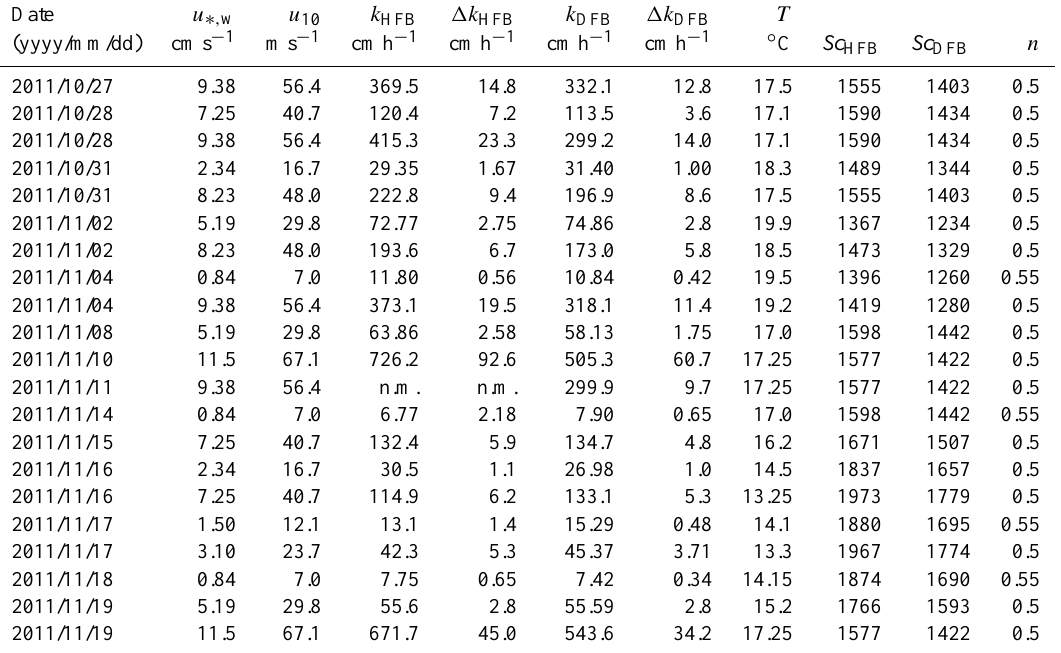
Table A1 summarizes all measured experimental data: fric- tion velocity, wind speed, mean water temperature, as well as both tracer’s transfer velocities and Schmidt numbers. Table A1. Transfer velocities k (not scaled to Sc =600) measured in the Kyoto high-speed wind-wave tank for tracers 1,4-difluorobenzene (DFB) and hexafluorobenzene (HFB) and their respective uncertainties 1k . “n.m.” means not measured. The wind speed u 10 and water- sided friction velocity u ∗ , kindly provided by the Japanese colleagues, are also given. T denotes the mean water temperature during the measurement. Schmidt numbers Sc of the tracers at this temperature are also